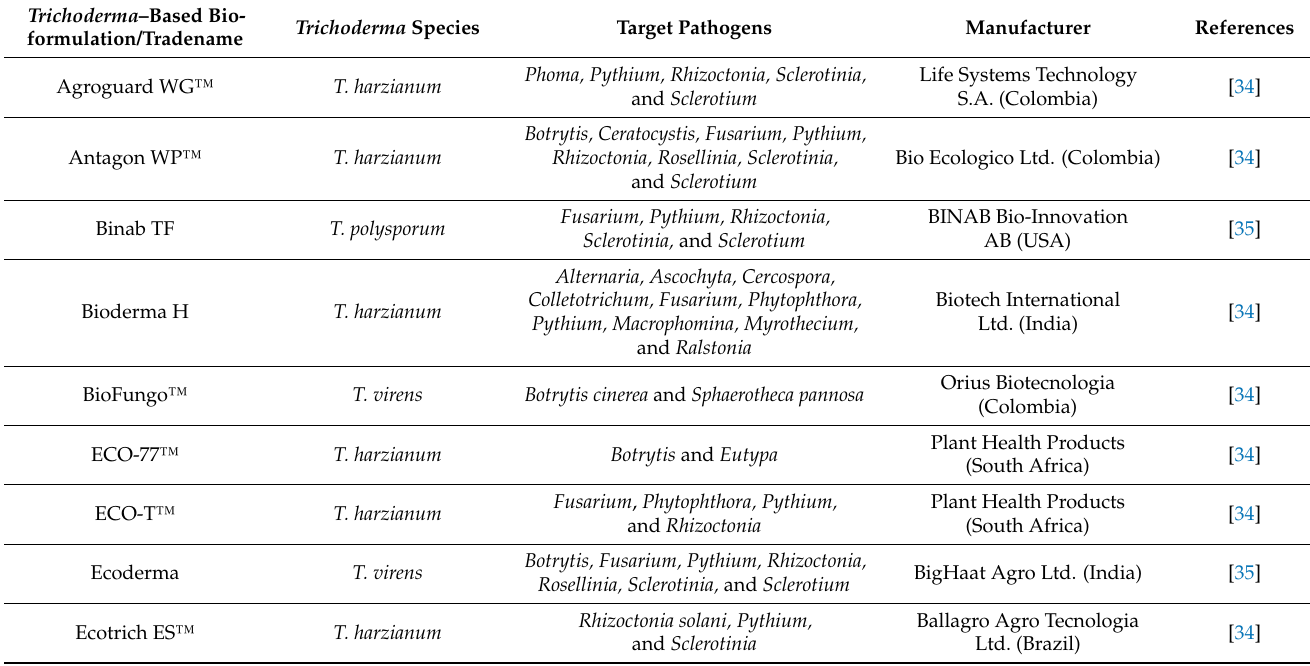
Table 1. Trichoderma –based commercial bioformulations controlling plant pathogenic